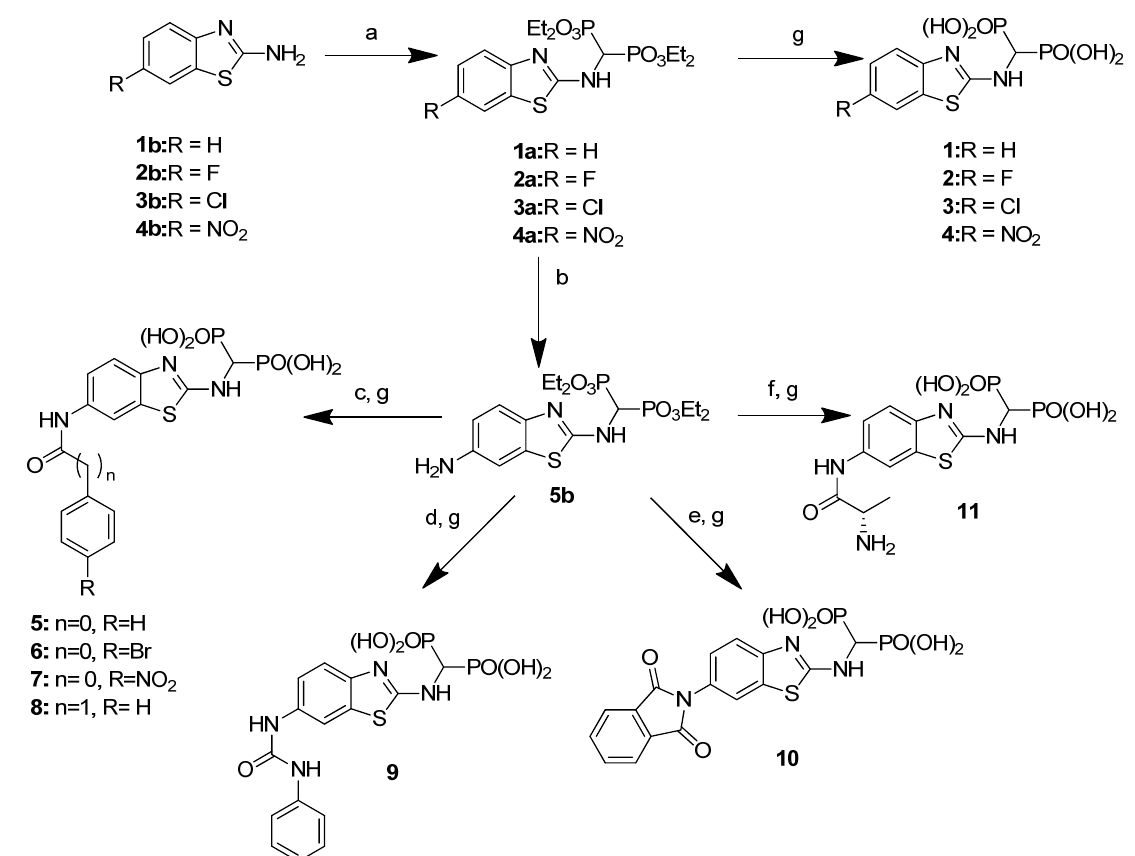
Figure 1. Synthesis of compounds 1–11 . Reagents and conditions: ( a ) HC(OEt) 3 , HP(OEt) 2 , 160°C, 6 h (15–53%); ( b ) H 2 , Pd/C 10%, EtOH, 3 bar, rt, 12 h (77%); ( c ) RCOOCl, NEt 3 , THF dry, 0°C → rt, 3–12 h (82%); ( d ) phenyl isocyanate, toluene dry, reflux, 2 h (57%); ( e ) phthalic anhydride, glacial AcOH, reflux, 4 h (54%); ( f ) EDC, DMAP, Boc-L-Ala, CHCl 3 , rt, 12 h (47%); ( g ) TMBS, CH 2 Cl 2 dry, rt, 24–48 h (40–96%).